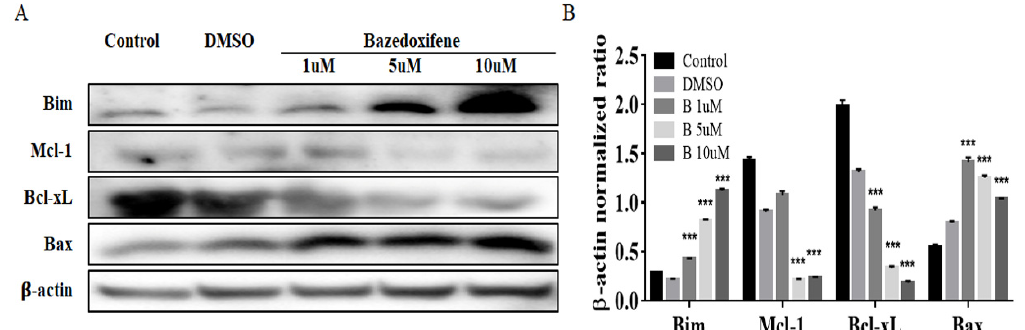
Figure 4. Expression analysis of apoptosis marker proteins in Bazedoxifene-treated SiHa cells. ( A ) Cells were treated for 48 h with the indicated doses of Bazedoxifene. Cell extracts prepared after treatment were resolved by SDS-PAGE and analyzed by Western blot analysis with antibodies against the indicated proteins. ( B ) The band intensities were quantitated. The loading control was β -actin. Bars indicate mean ± standard deviation of three independent experiments performed in triplicate (***, p < 0.001 vs. control). B: